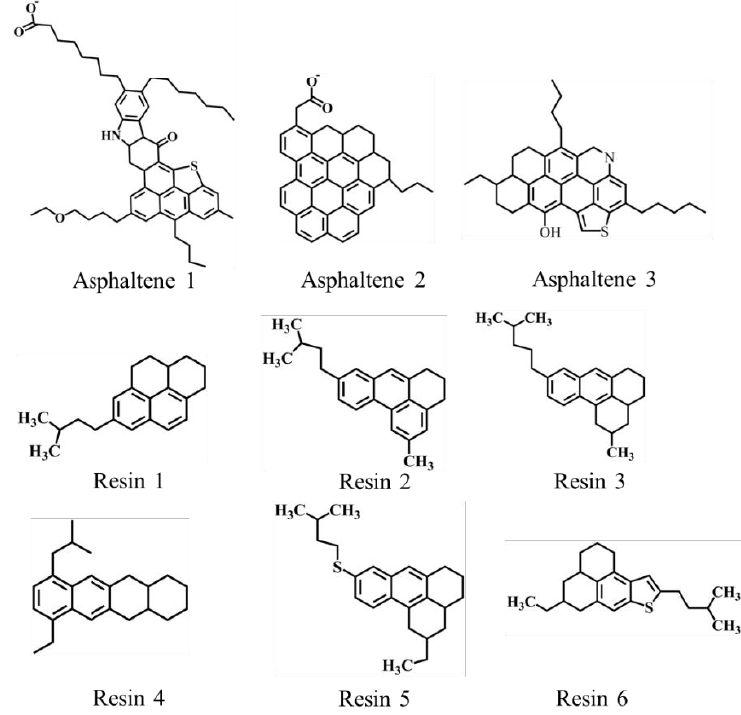
Figure 1. Asphaltene and resin molecules used in the simulations.